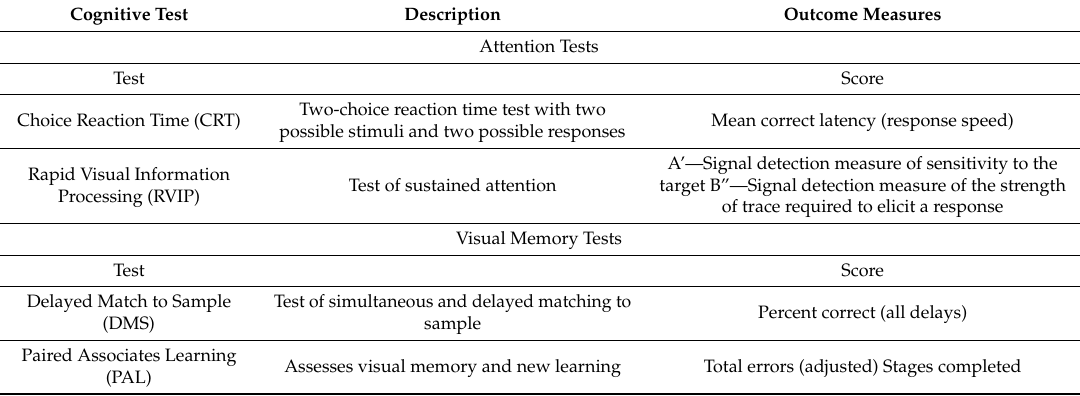
Table 1. Cognitive Test Battery